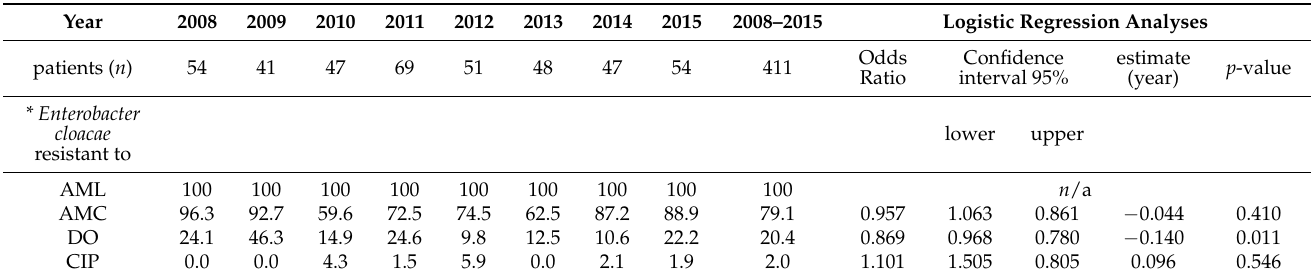
Table 4. Temporal evolution (2008 to 2015) of the occurrence of antibiotic resistances to amoxicillin (AML), amoxicillin/clavulanic acid (AMC), doxycycline (DO), ciprofloxacin (CIP) was analyzed using logistic regression methods. Trend in the occurrence of antibiotic resistances (%) in * Enterobacter cloacae .